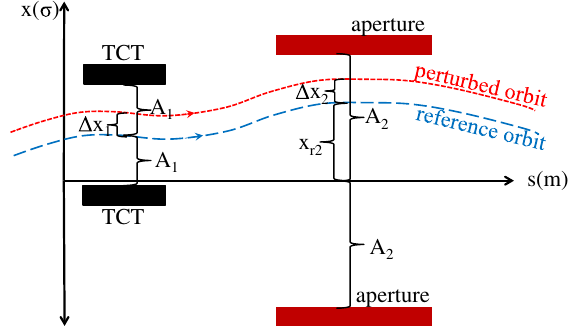
Fig. 9. During the qualification of the protection, right after